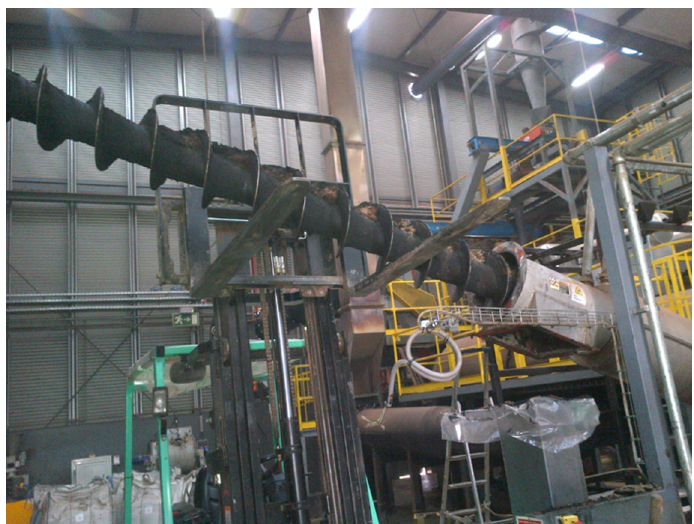
Figure 11. Propeller of the first auger in the cooling system. Both the shaft and the propeller are covered in a black material, similar to coal, indicating that the material may have been exposed to high temperatures, or an excessive residence time.